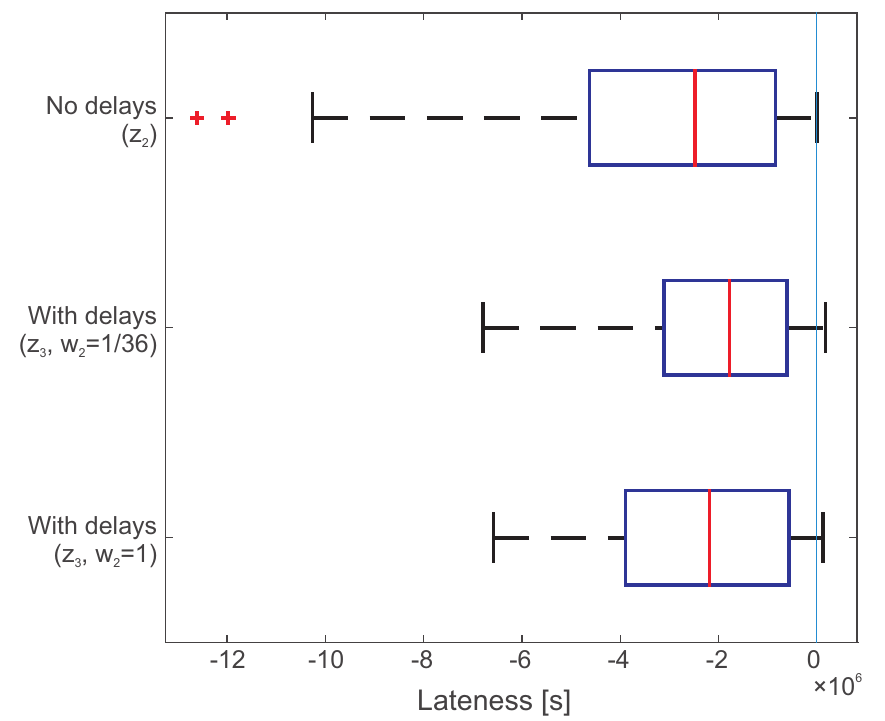
Figure 10. Lateness of input